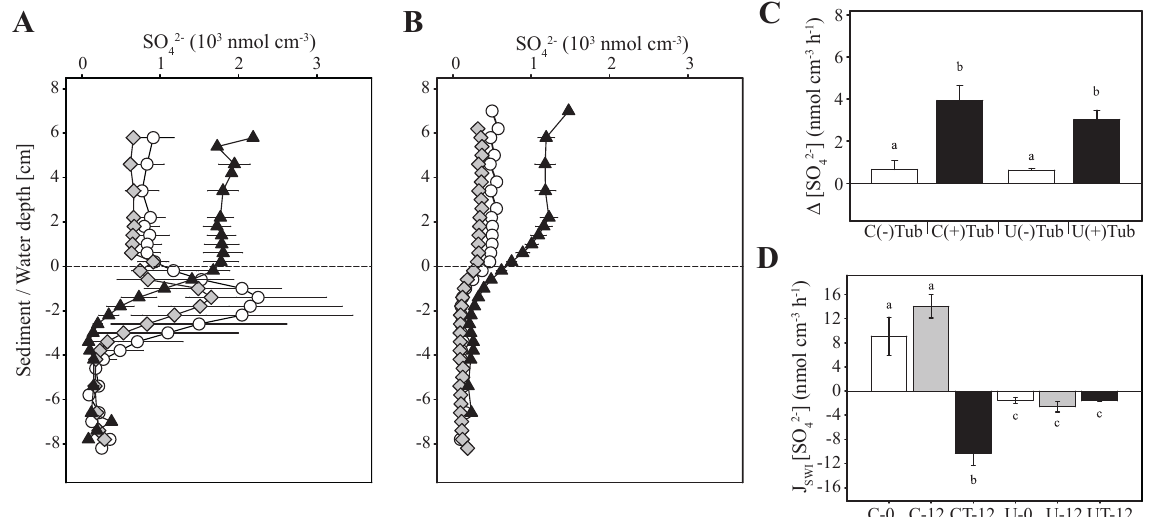
Figure 4. Dissolved sulfate concentration profiles in uncontaminated ( A ) and U-spiked sediment ( B ) in the different treatments: at initial conditions [C-0] and [U-0] ( (cid:13) ) and after 12 days without [U-12] ( ♦ ) or with [UT-12] ( N ) T. tubifex worms in the sediment. The bar chart ( C ) corresponds to the net accumulation rate in the water column after 12 days. The bar chart ( D ) shows the integrated diffusive fluxes at the sediment–water interface estimated using PROFILE software. Means ± SD ( N = 3). Different letters correspond to significant differences between